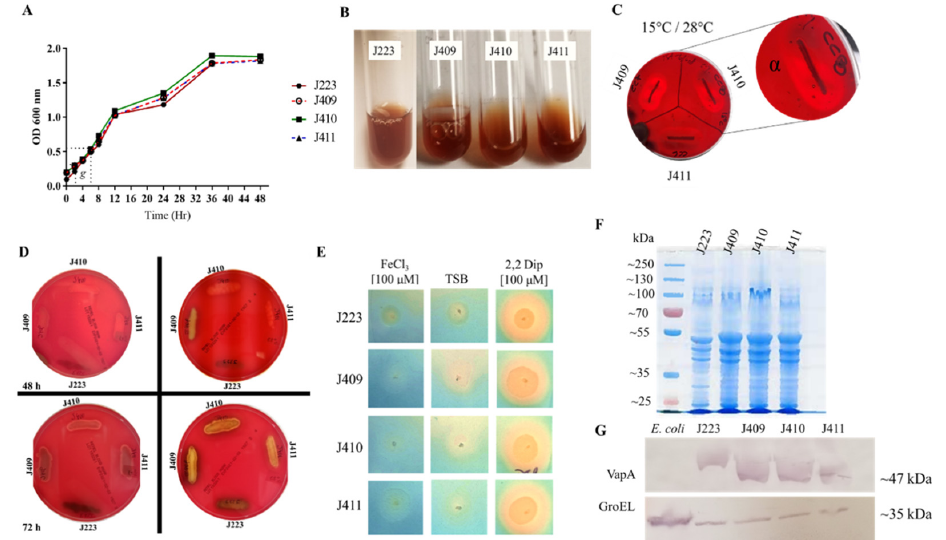
Figure 1. Phenotypic characteristics of atypical and typical A. salmonicida . ( A ) Growth curve of A. salmonicida J409, J410, and J411 on TSB media at 15 °C; ( B ) A. salmonicida melanin-brown pigmentation development on the stationary phase; ( C ) Hemolytic activity evaluated at 15 °C and 28 °C on 5% salmon blood-agar plate for of A. salmonicida J409, J410, and J411. The close-up shows α -hemo-